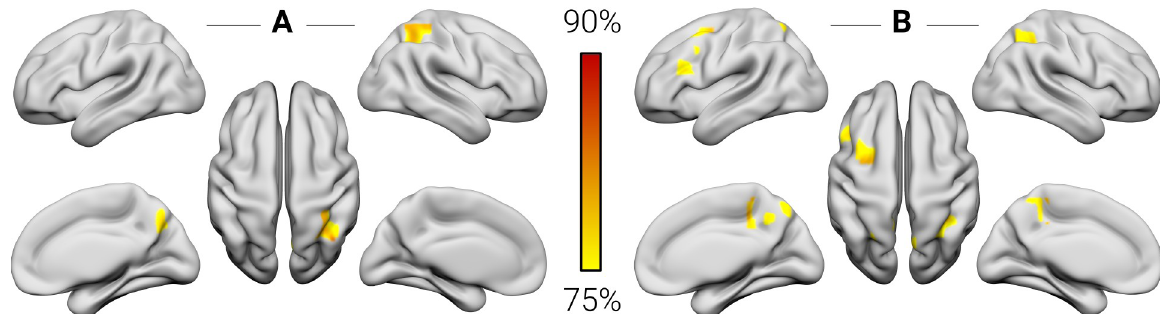
Fig 1. Regional functional classification results. The color bar indicates the peak accuracy for the classification of children with dyscalculia versus typical controls ( P < 0.001, corrected by permutation testing) based on the amplitude of low-frequency fluctuations and the regional homogeneity of the signals. The numerical data used in this figure are included in S1 Data. https://doi.org/10.1371/journal.pbio.3001407.g001 classifier was able to significantly distinguish between the groups based on the amplitude of low-frequency fluctuations and the regional homogeneity of the signals. Peak classification accuracy for the amplitude of low-frequency fluctuations was 86.67% in the right PPC and 80% in the right precuneus (PC) ( P < 0.001, corrected by permutation testing) (Fig 1A, Table 2). Peak classification accuracy for regional homogeneity was 86.67% in the right PC and the left dorsolateral prefrontal cortex (DLPFC), 83.34% in the right and left PPC and the left DLPFC, and 76.67% in the left frontal pole ( P < 0.001, corrected by permutation testing) (Fig 1B, Table 2).